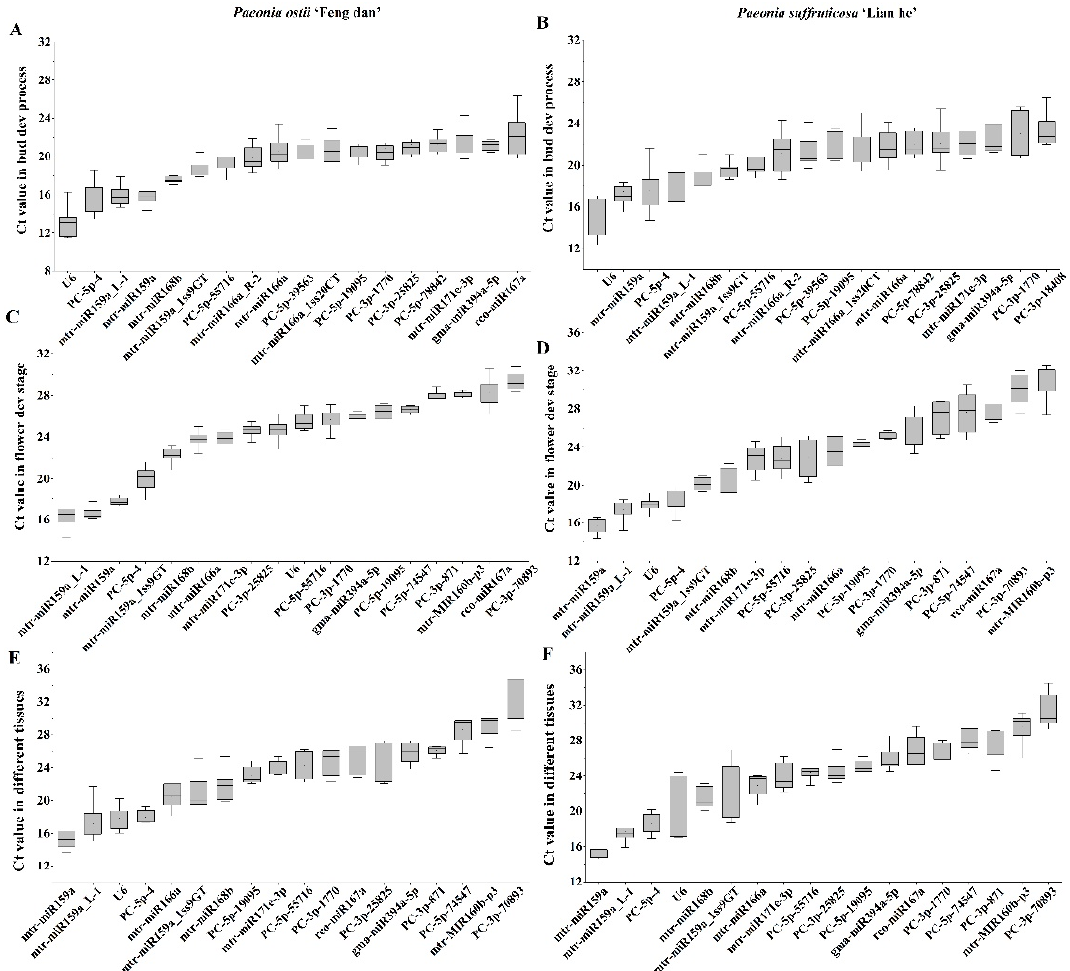
Figure 5. Cycle threshold (Ct) variation of candidate reference miRNAs. The box–whisker plot represents the Ct changes in buds, flower development stages, tissues of Paeonia ostii ‘Feng dan’ ( A , C , E ), and Paeonia suffruticosa ‘Lian he’ ( B , D , F ).